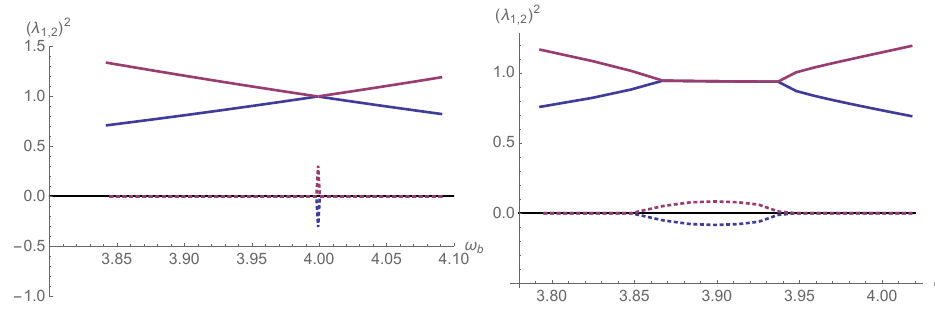
Figure 41 . First two normal modes squared developing an imaginary part (dashed) upon fusing. The plots correspond to (cid:30) b = (cid:0) : 001 (left) and (cid:30) b = (cid:0) : 01 (right). In the left plot the imaginary parts have been rescaled by a factor 500 to be